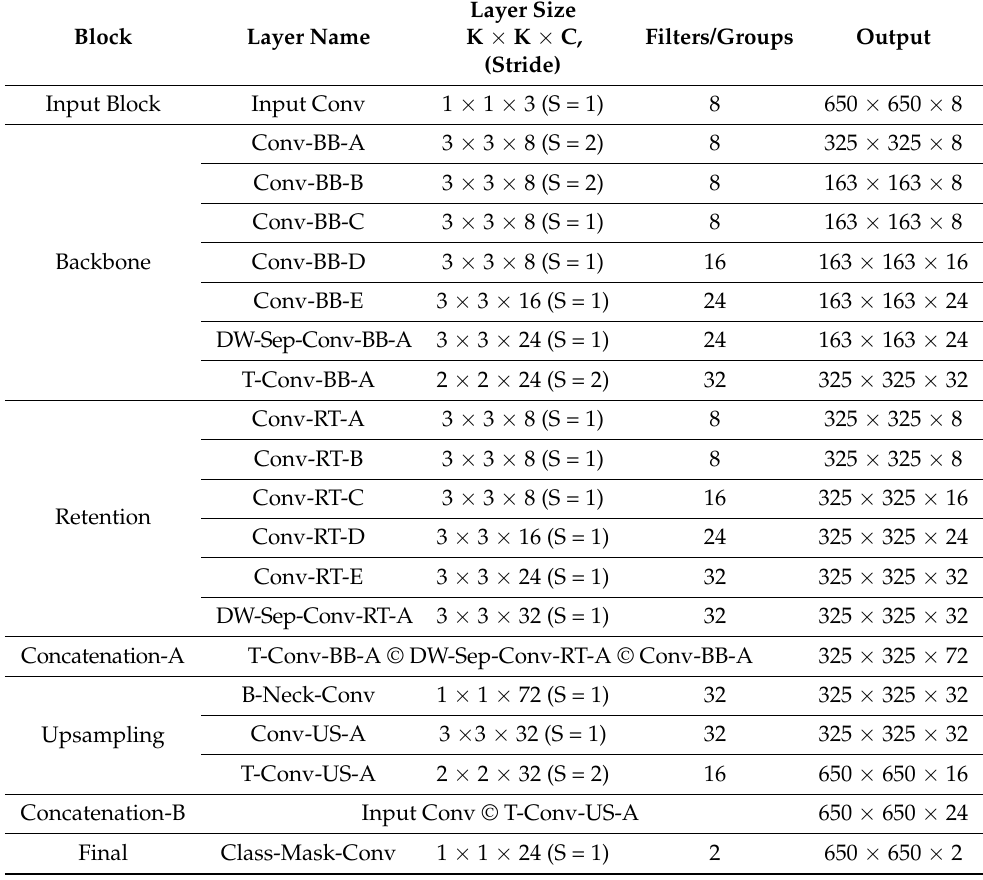
Table 3. Feature map size details of the VSUL-Net